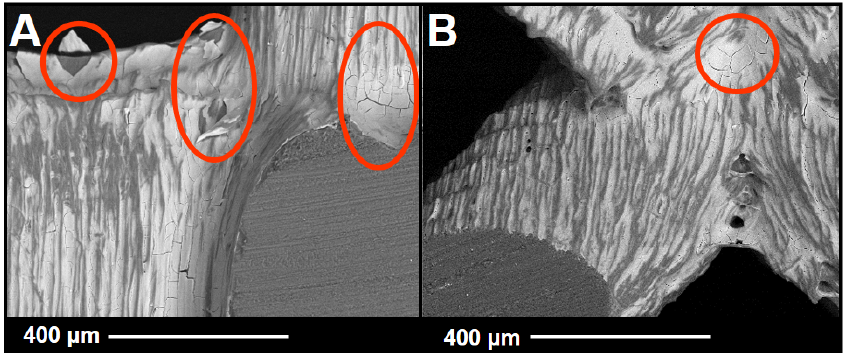
Figure 10. SEM micrographs showing accumulation of material and detachment towards the angles (example of the diamond structure): ( A ) Zone 1: detachment in the struts; ( B ) Zone 2: detachment in the joint of struts.